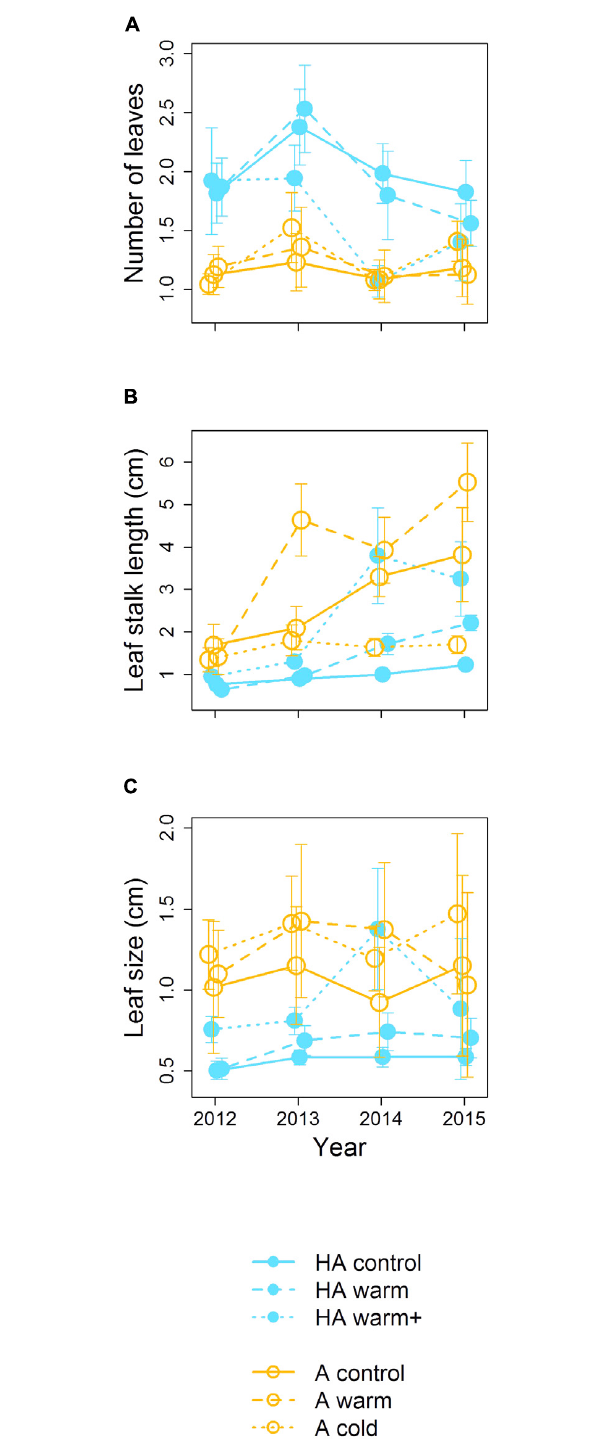
FIGURE 4 | Leaf traits ( A–C : Number of leaves, Leaf stalk length and Leaf size) in transplants (dashed and dotted lines) and controls (solid lines) from high alpine (blue, filled symbols) and alpine origin (orange, open symbols) over the study period. Error bars indicate 95% confidence intervals. The positions of the different time series are slightly shifted along the x -axis to facilitate readability.